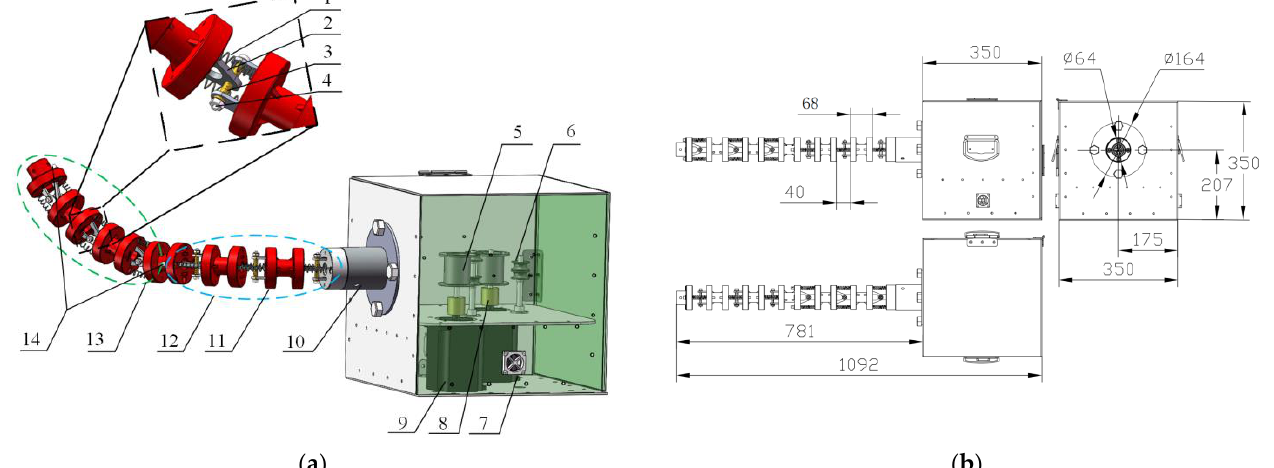
Figure 3. ( a ) The overall model of the CDFM: (1) tendon; (2) support; (3) graphite copper sleeve; (4) shaft; (5) reel; (6) pulley; (7) cooling fan; (8) coupling; (9) stepper motor; (10)flange base; (11) con- necting rod; (12) proximal arm segment; (13) distal arm segment; (14) cable locking. ( b ) CAD drawings with different viewing angles of the CDFM (the unit is mm).